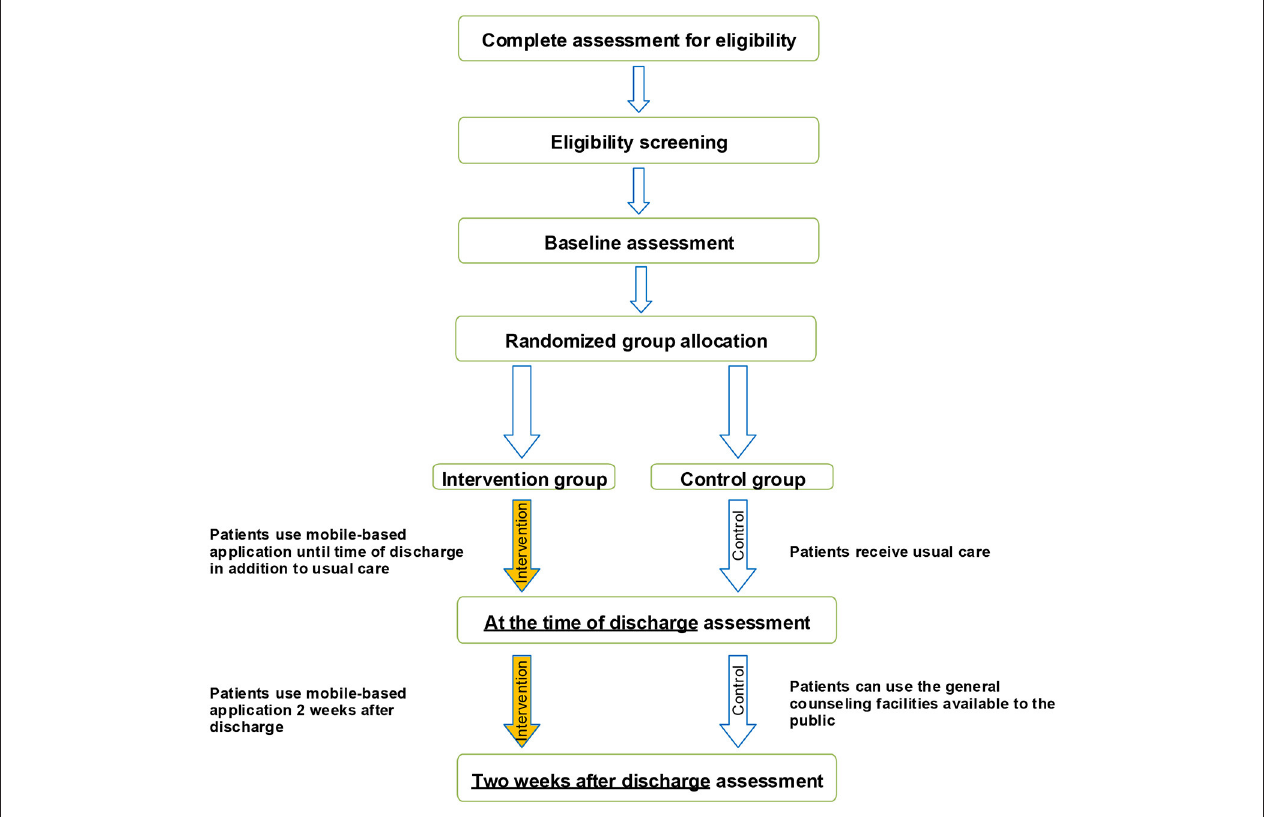
FIGURE 1 | Schematic of the study